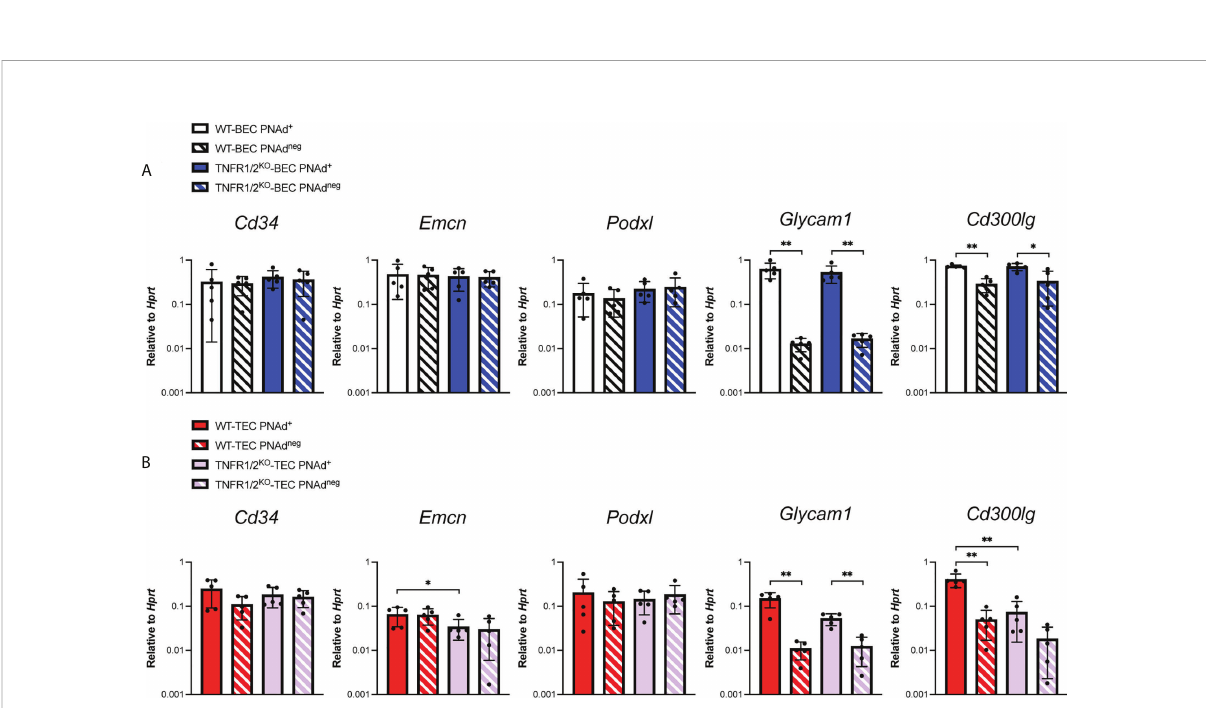
FIGURE 7 Tumor necrosis factor receptor signaling regulates Podxl and Cd300lg expression in PNAd + TEC. C57BL/6 WT or TNFR1/2 -/- mice were I.P. injected with B16-OVA cells and tumors were harvested 14 days after implantation. LN were harvested from non-tumor-bearing mice. (A, B) Endothelial cells were sorted from CD45 + depleted LN and I.P. tumor suspensions, and the expression levels of indicated RNA transcripts were determined by qPCR, as described in Methods. Data from one experiment presented as 2 - D CT relative to Hprt, n=5 LN or I.P. tumors per group. (A-B) Results are mean ± SD analyzed by unpaired Welch ’ s t-test. *p<0.05, **p<0.01, all other paired bar comparisons are not signi fi cant (p>0.05) and have been omitted for clarity.